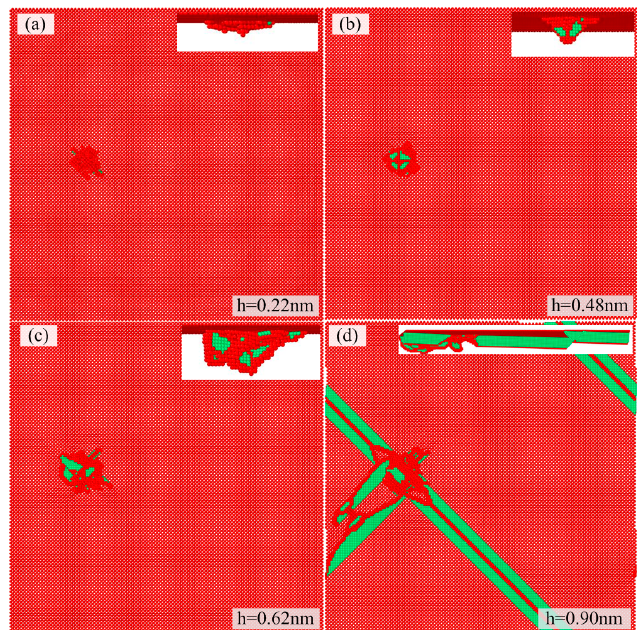
Figure 12. Atom configuration during indentation process with residual compress stress λ = − 0.53 at various indentation depths: ( a ) 0.22 nm; ( b ) 0.48 nm; ( c ) 0.62 nm; ( d ) 0.90 nm. The green color shows stacking faults.